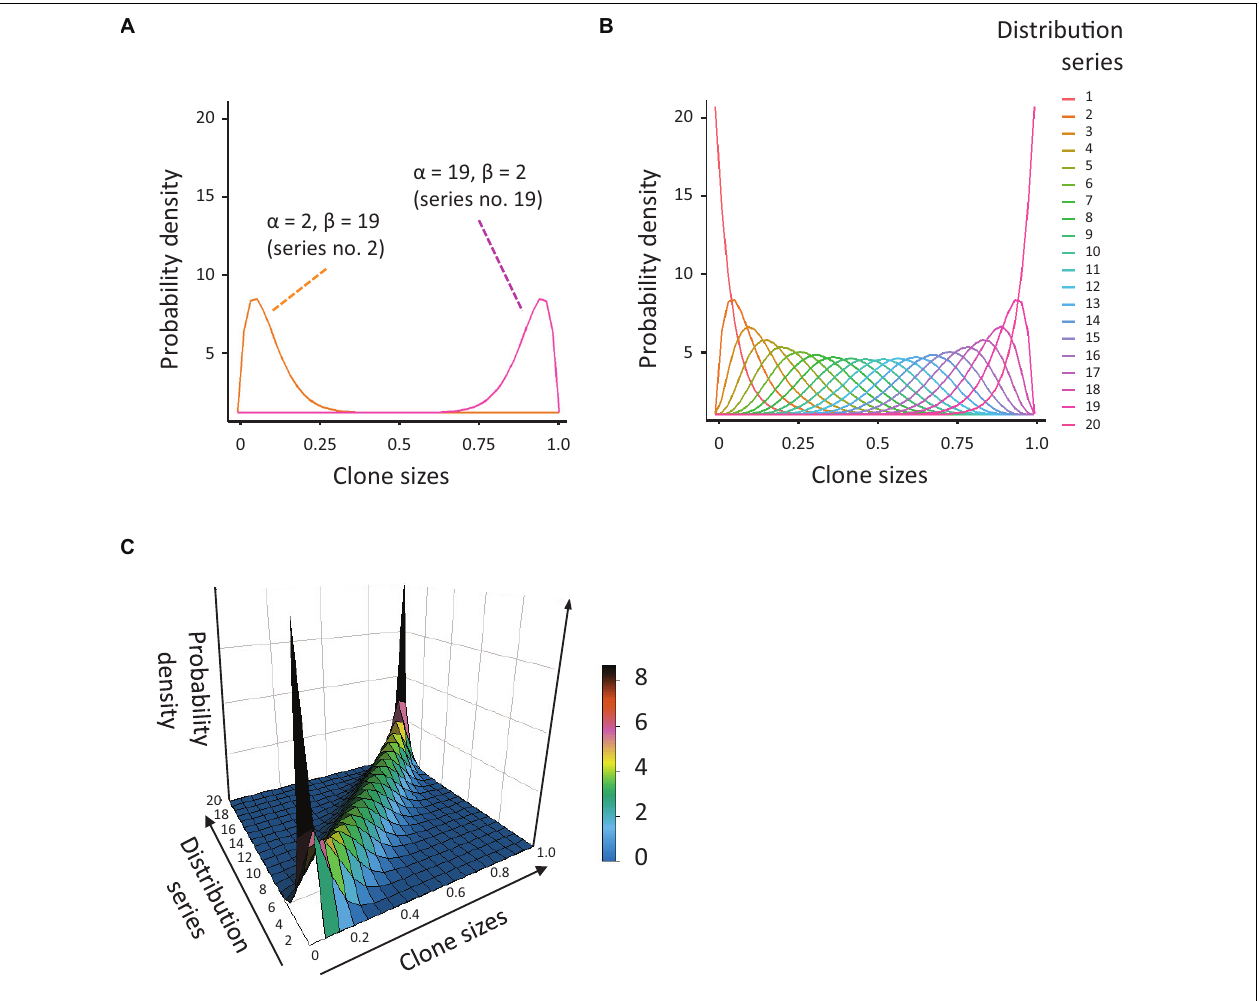
FIGURE 1 | Simulation of population diversity based on the beta distribution. (A) Probability density distributions, based on the beta distribution, generated by reciprocal variation of the alpha and beta coefficients. The orange curve represents the distribution for alpha = 2 and beta = 19 (many small clones and a few big), the pink curve is the distribution for alpha = 19 and beta = 2 (many large clones and a few small). (B) Overview of all probability distributions tested. Note that these vary from highly skewed to near-normal. (C) 3-dimensional depiction of the probability distributions shown in Figure